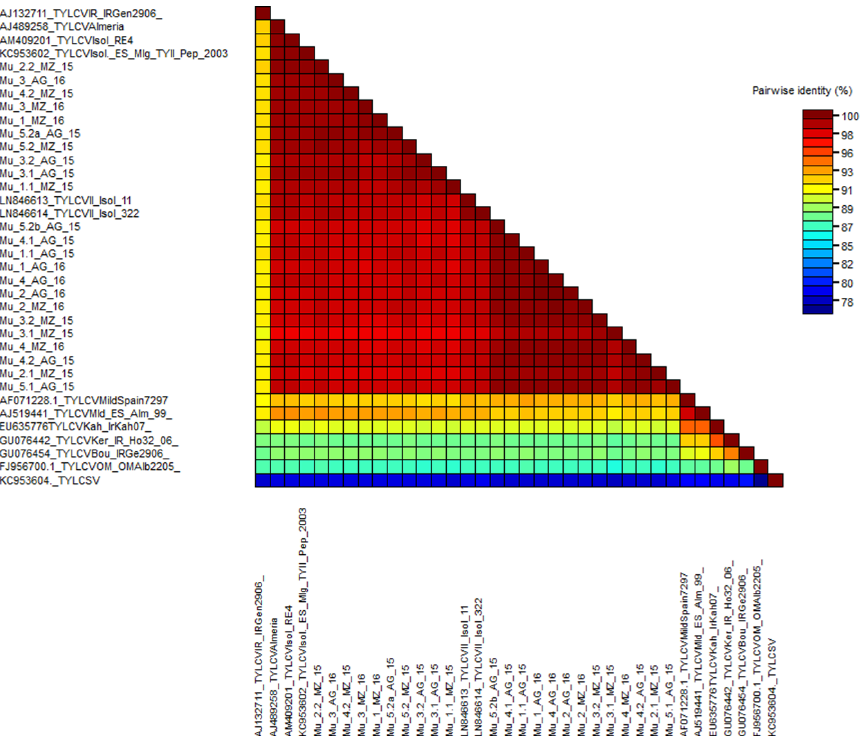
a Resistant plants showing TYLCV symptoms; ND: No cultivar information available; b Sequences are named as Mu field number locality: year. In bold, samples characterized by RCA-HTS.